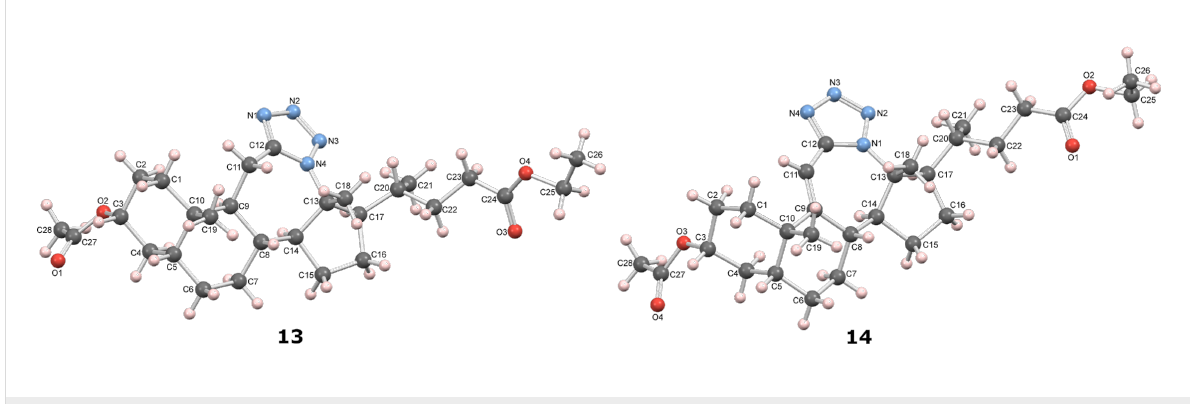
Figure 3: Mercury [51] drawing of the molecular structures of compounds 13 and 14 , with labelling of nonhydrogen atoms. Hydrogen atoms are drawn as spheres of arbitrary radii.